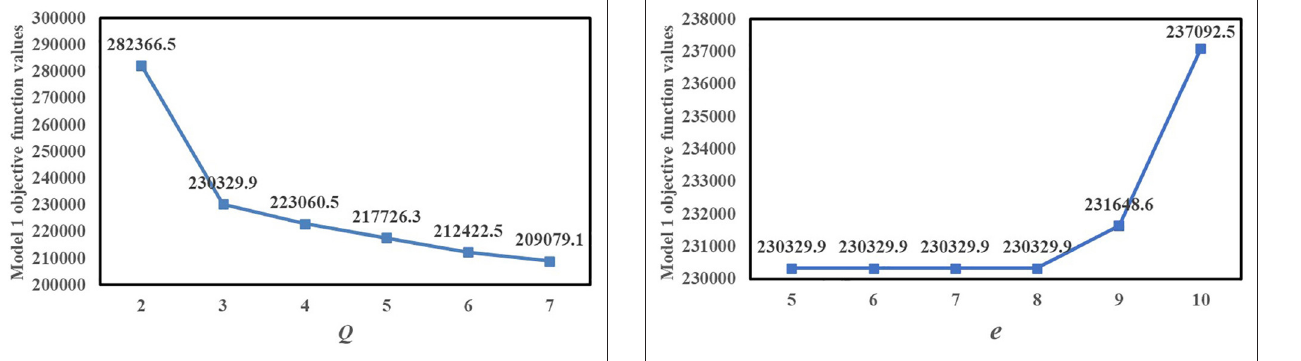
FIGURE 3 | Variation of Model 1 objective function value with Q . FIGURE 4 | Variation of Model 1 objective function value with e .